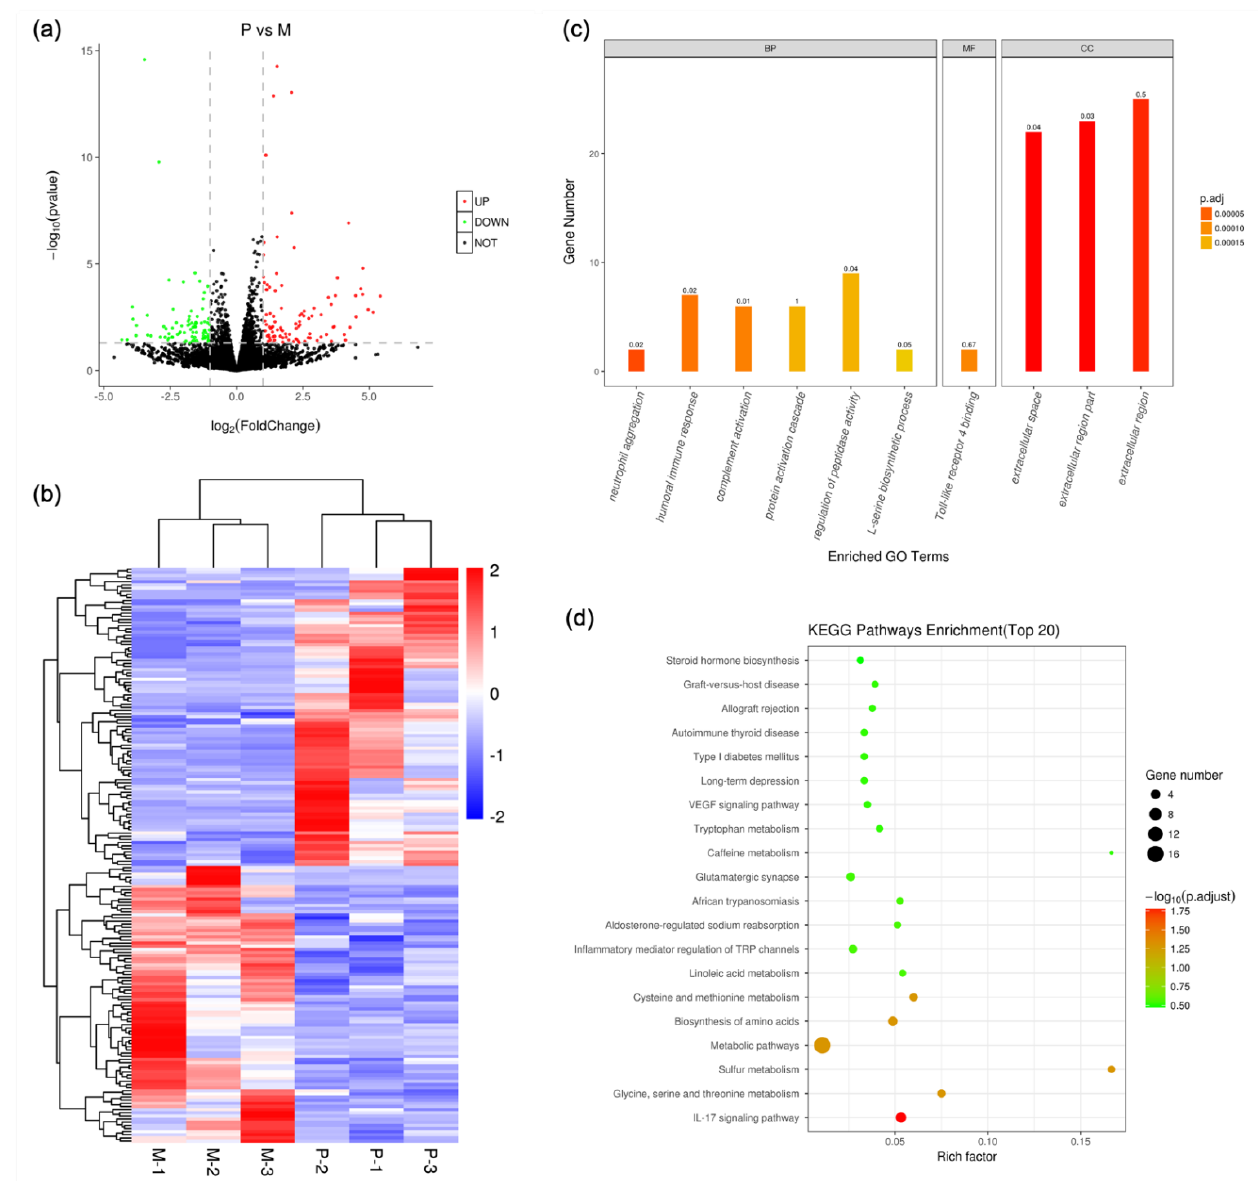
Figure 3. Transcriptomics. ( a ) Differential genes; ( b ) clustering analysis; ( c ) GO function annotation analysis; ( d ) significant KEGG pathway.